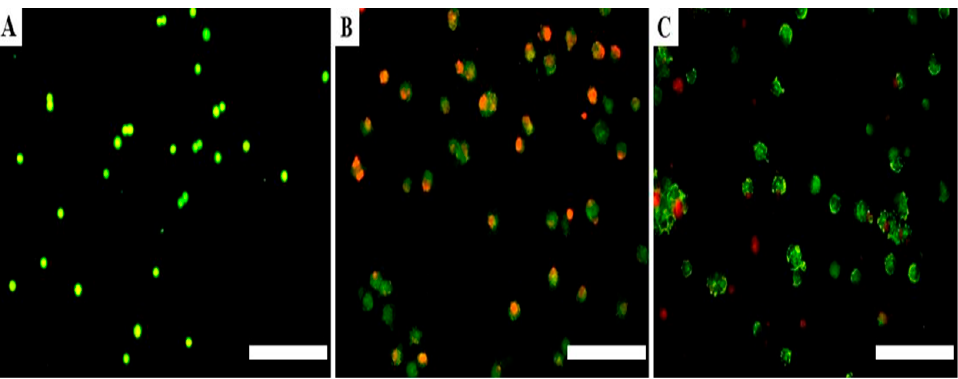
Figure 4. A549 cells with different features of apoptosis as identified with dual staining with AO and PI after 48 h of transfection. MMP8.1.AA and Hs.Cas9.MMP8.1.AB. ( A ) Non-transfected cells, ( B ) Hs.Cas9.MMP8.1.AA ( C ) Hs.Cas9.MMP8.1.AB. Scale 500 µm.